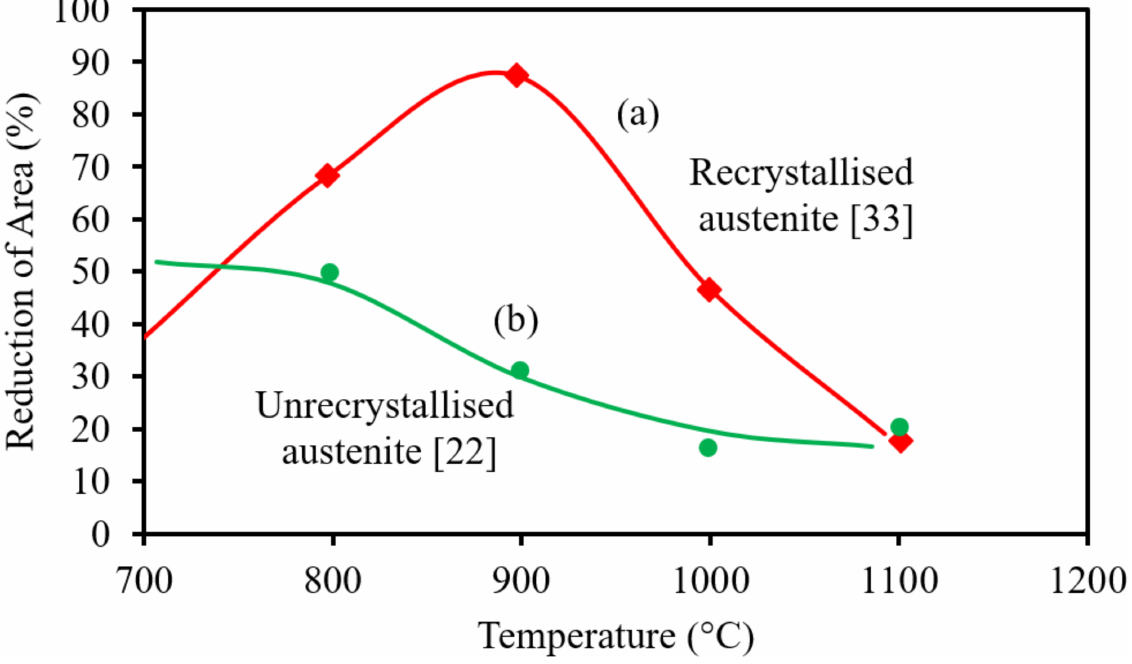
Figure 29. Hot ductility curves for high Al TWIP steels with the same V content, 0.011% V, (a) recrys- tallised austenite (b) un-recrystallised austenite. Compositions of TWIP steels were: Recrystallised top curve –21% Mn, 0.56% C, 1.3% Si, 1.50% Al, 0.011% V and 0.012% N [33]. Unrecrystallised bottom curve –18% Mn, 0.61% C, 0.2% Si, 1.54% Al, 0.011% V and 0.007% N